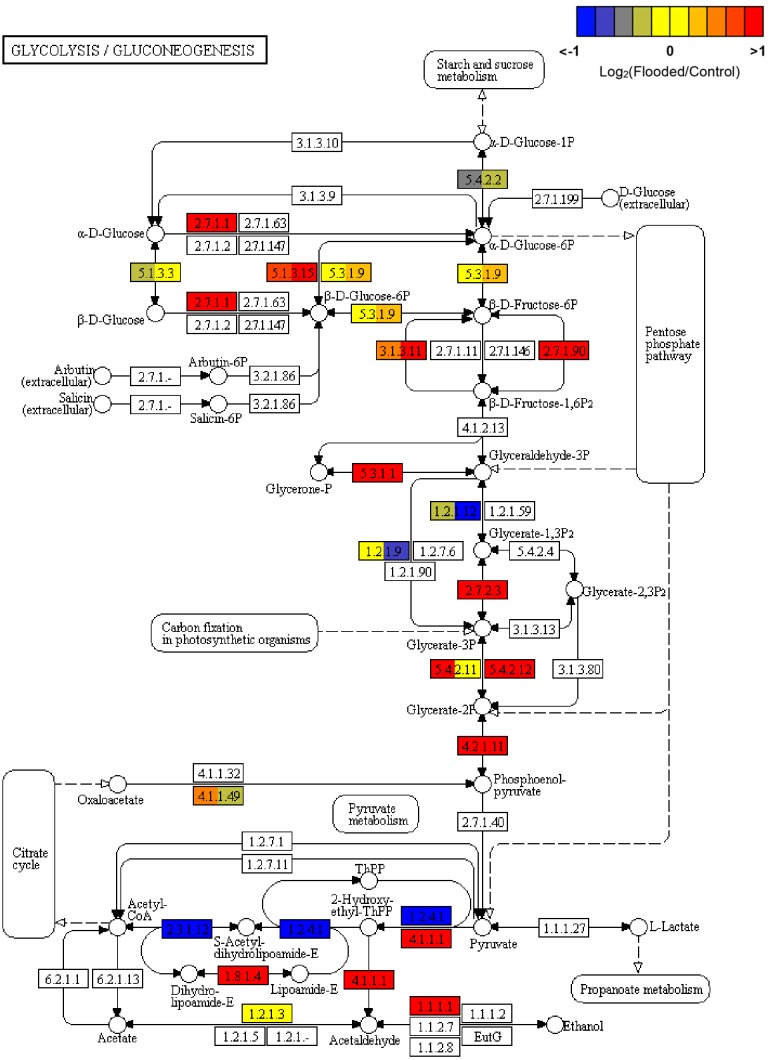
KEGG map of Glycolysis and Gluconeogenesis (map00010) pathway, rendered by Pathview (Luo et al., 2017). Each box is divided in three sub-boxes and represents a specific enzymatic step with the relative expression of the corresponding genes in Flooded versus Control roots, calculated as log2-ratio at T1, T2, and T6 (from left to right).